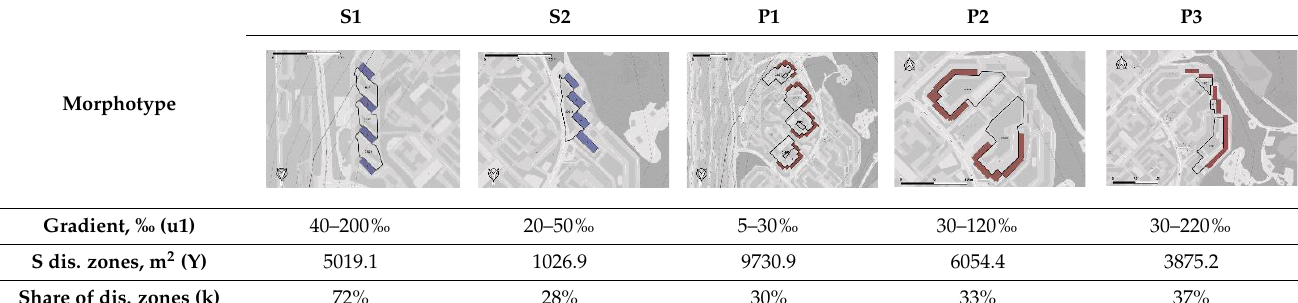
Table 8. Results of simulation of Neighborhood 403, Murmansk, needed to determine the share of discomfortable zones in the residential development on the sloping lands of the Arctic zone of the Russian Federation.